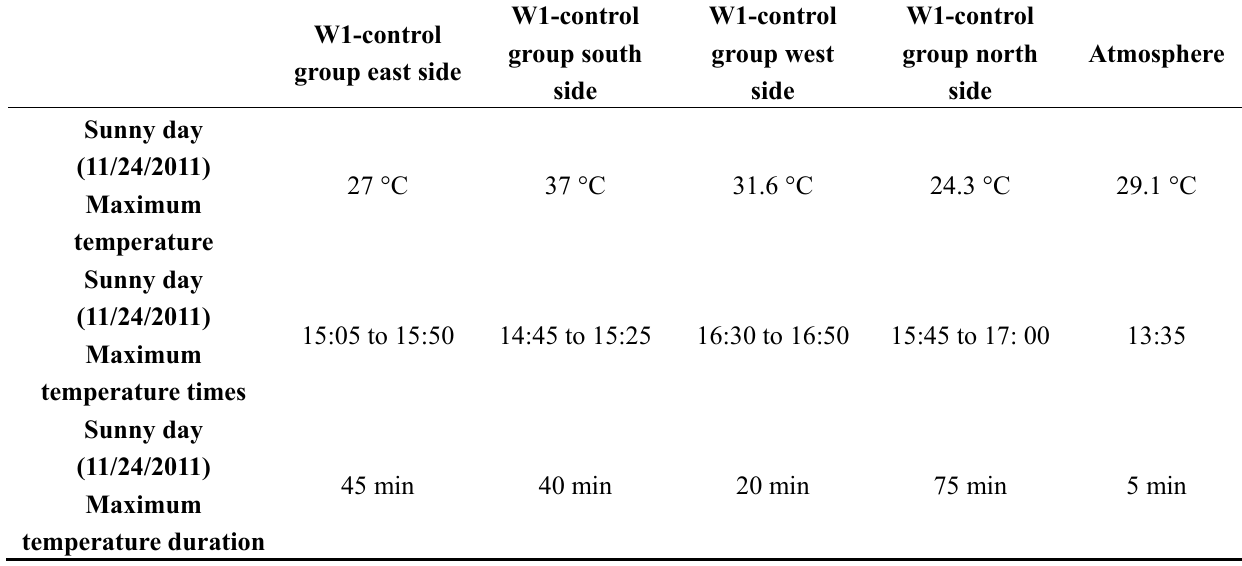
Table 4. Maximum Temperature Times Inside Simulated Wall Concrete